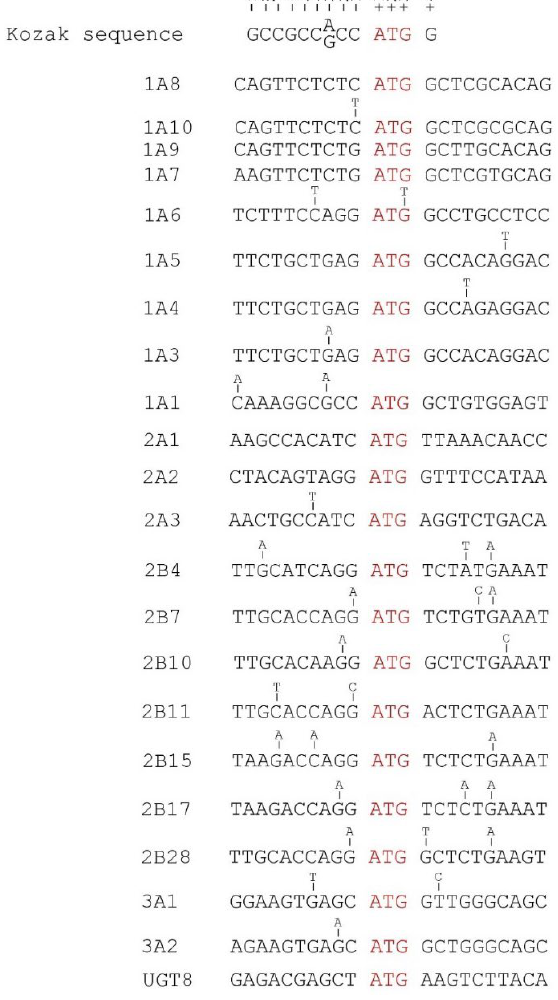
Figure 6. Somatic mutations within and adjacent to the Kozak sequence of UGT genes in TCGA tumors. Data shown are the Kozak consensus sequence and the start codon ATG (positioned as +1, +2 and +3) and 10 nucleotides up (positioned as −1 to −10)- and down (positioned as +4 to +13)-stream of 22 UGT genes. Mutations within the Kozak sequences (as defined from position −9 to position +4) and adjacent sequences of UGT genes are indicated above the sequences. The start codons of the 22 UGT genes are highlighted in RED.